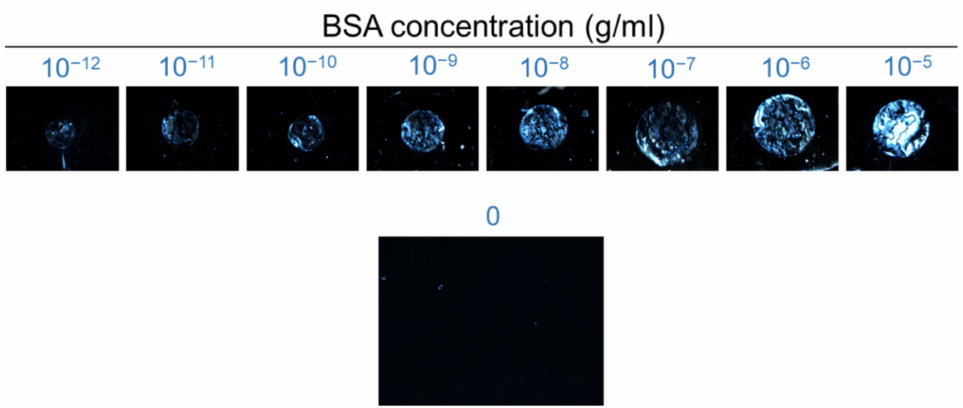
Figure 4. Optical textures of planarly aligned LCLC in the presence of BSA. The LCLC-based protein detection was performed with an aqueous solution of 14-wt% DSCG as the sensing medium in contact with 10 − 12 –10 − 5 g/mL BSA immobilized on the PI-coated glass surface. The micrograph at the bottom displays a completely dark texture of a reference of dried DI water containing no